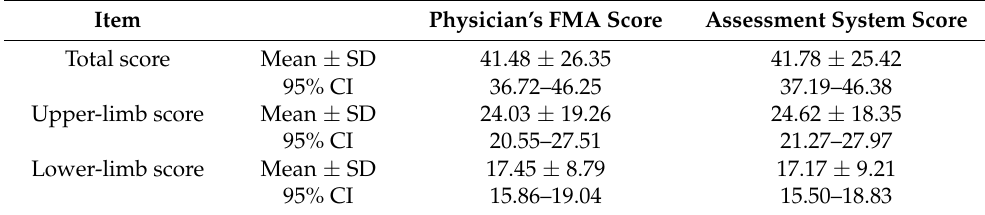
Table 2. Intelligent rehabilitation assessment system score and physician’s FMA score.